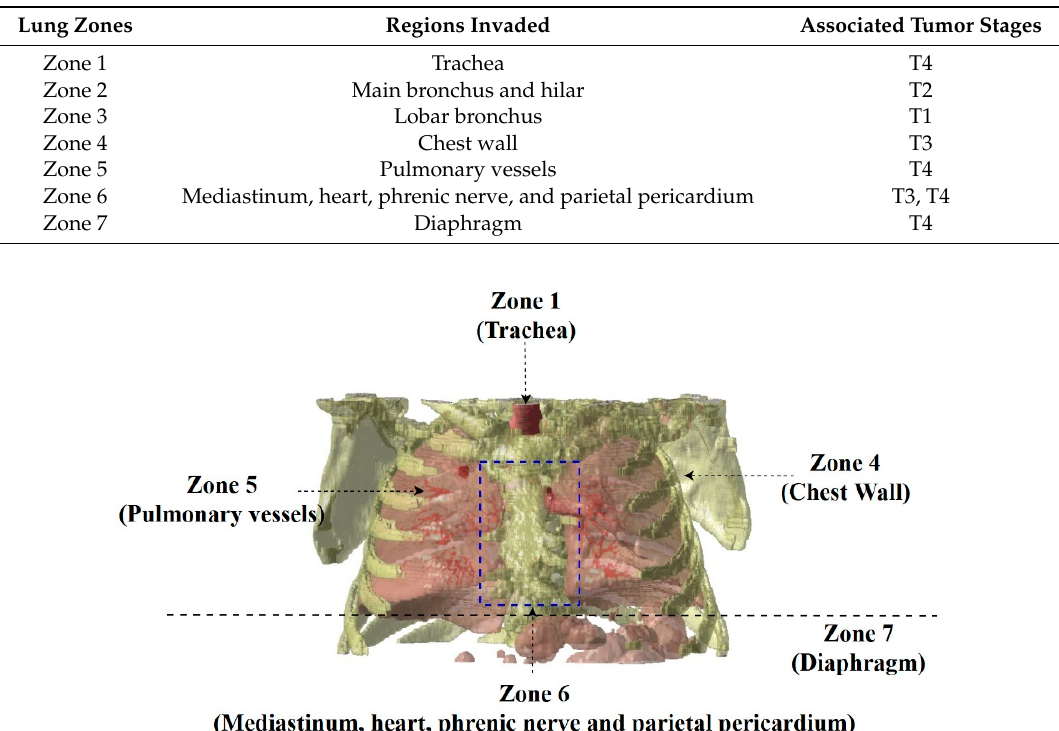
Figure 11. Di ff erent locational zones of the Figure 11. Different locational zones of the lungs.